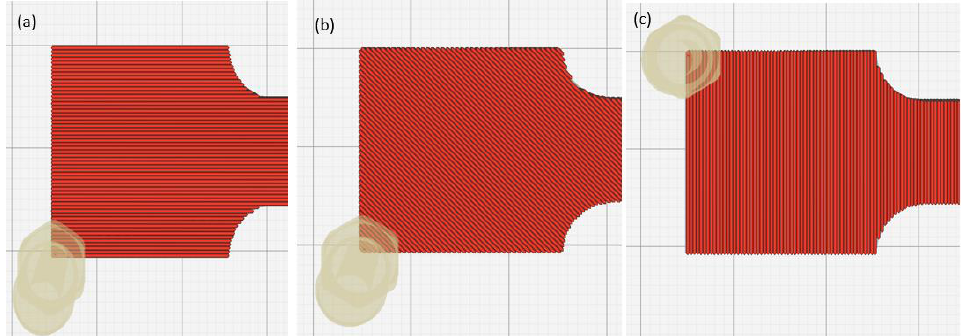
Figure 2. Printing Directions of ABS: ( a ) 0 orientation; ( b ) ±45 orientation; ( c ) and 90 orientation.